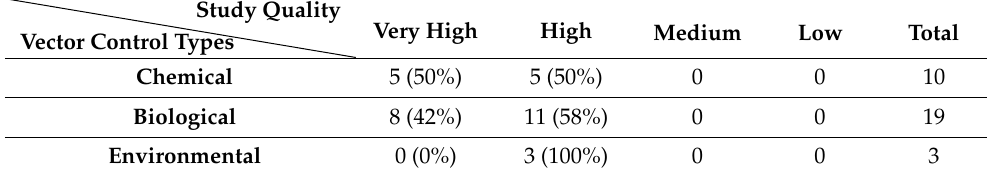
Table 3. Table showing the distribution of study quality with respect to the vector control types. Study Quality TypesStudy Vector Control